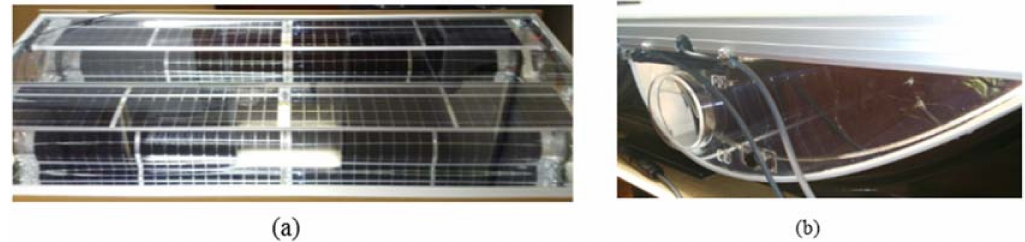
Figure 11. Solarus C-PVT panel: ( a ) the top view and ( b ) side